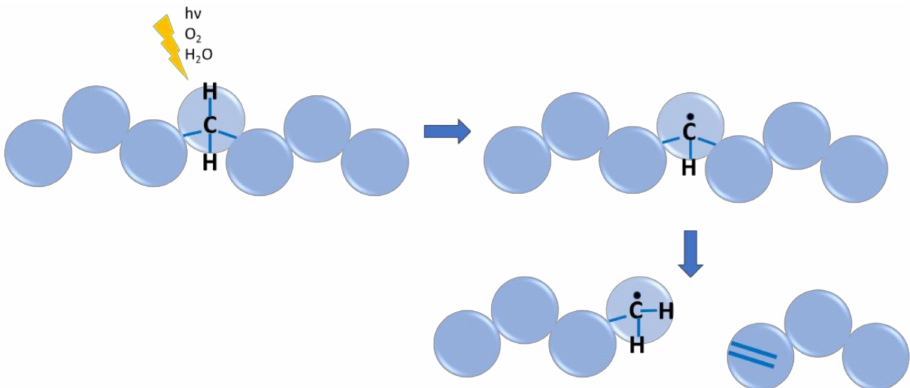
Figure 7. Schematic representation of polymer degradation under environmental conditions starting from H-atom abstraction with consecutive polymer chain β